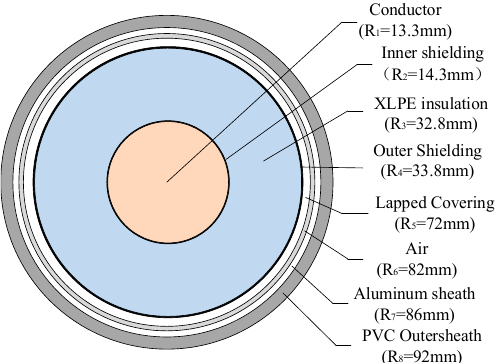
Figure 2. Configuration of the ampacity experimental cable and structural model used for Comsol Multiphysics. R x is the corresponding radius of each layer.